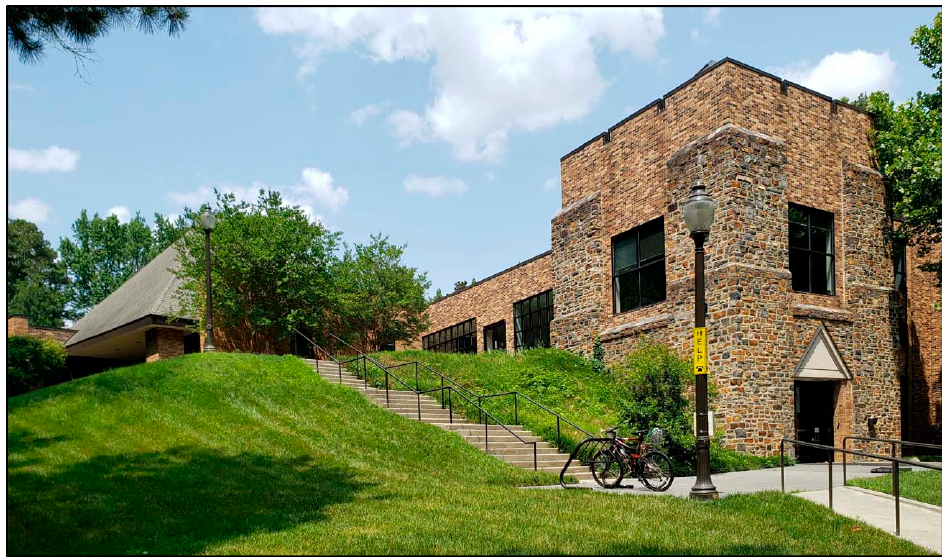
Figure 11. Freeman Center for Jewish Life at Duke, Exterior View from Southwest. Image Credit: © 2019 Jeremy Kargon.